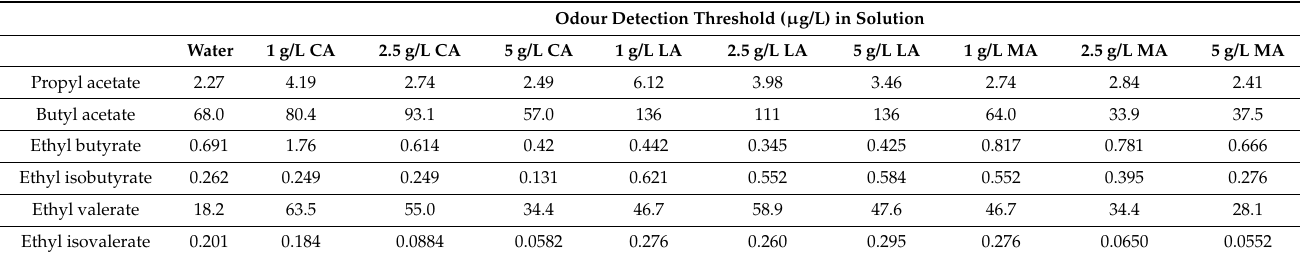
Table 1. Odour detection threshold of esters and esters added with organic